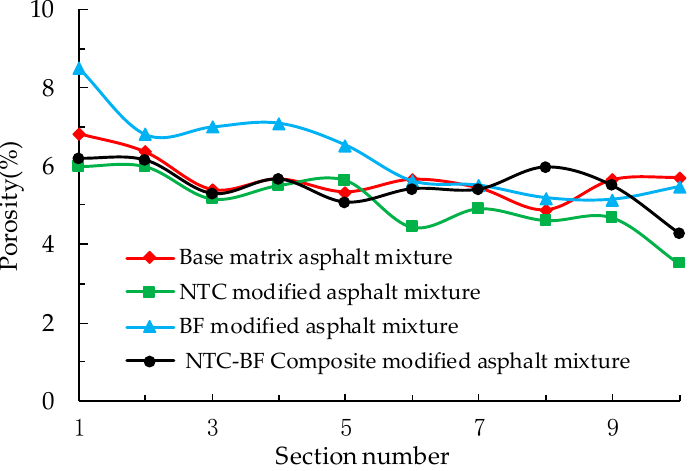
Figure 11. Longitudinal pore distribution map of asphalt mixtures.